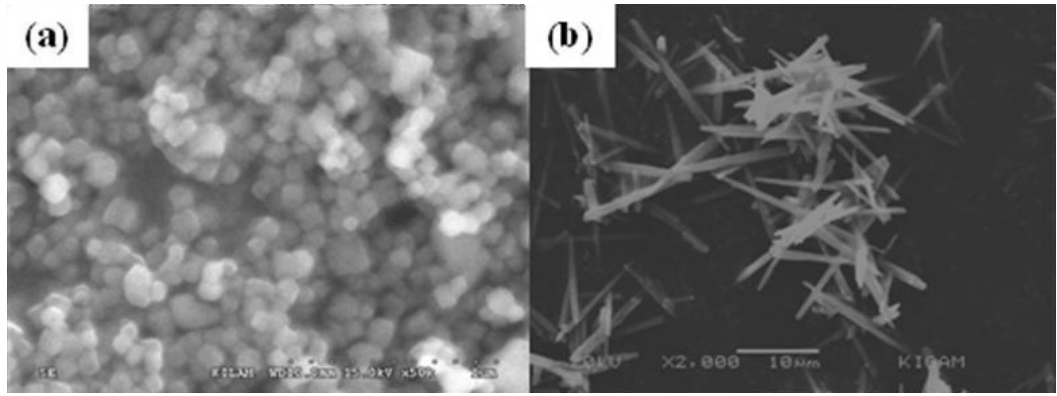
Figure 9. SEM images of synthesized calcite and aragonite. (a) Rhombohedral calcite of less than 100 nm and (b) needle-like